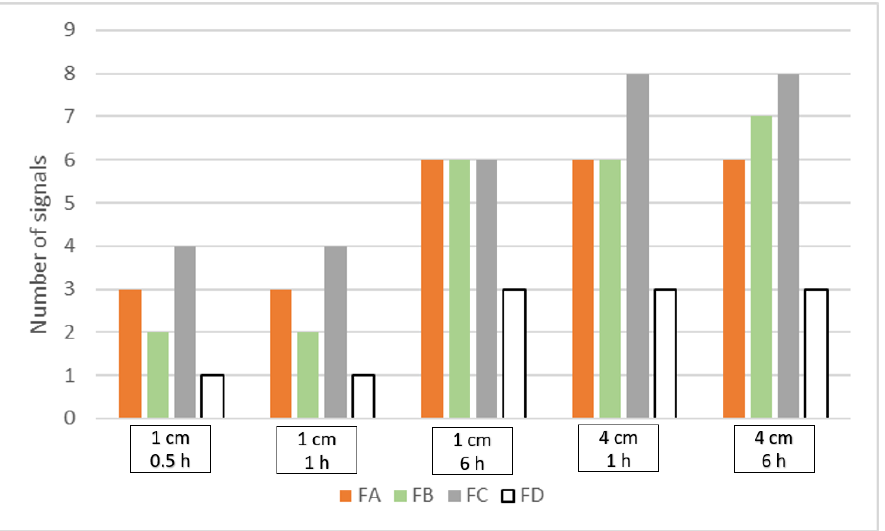
Figure 3. Comparison of a number of signals detected on the electropherograms registered in 220 nm for the extracts obtained in different high temperature extraction (HTE) conditions from four standard fabrics FA-FD.